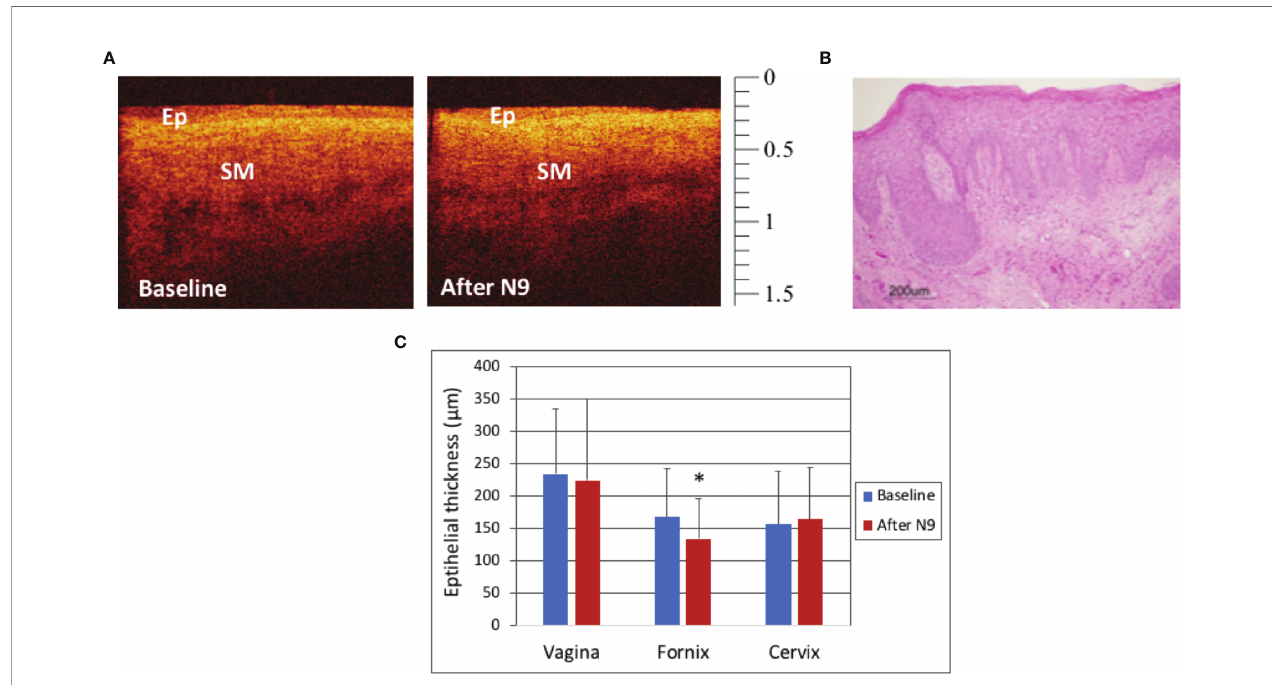
FIGURE 4 | Optical Coherence Tomography (OCT) and Histology Findings after 2 doses of Nonoxynol-9 (N9, 14 hours apart) - OCT image of the fornix in a mensing macaque before and after N9 application (A) . The epithelium (Ep) had very subtle changes with slight thinning in the fornix noted after N9. (OCT calibration bar is in mm, with small tick mark = 100 m m). Hematoxylin and Eosin (H&E) staining of vagina of a mensing macaque after N9 ( B , scale bar 200 m m). Epithelial thickness before and after 2 doses of N9 (14 hours apart) was signi fi cantly thinned in the fornix ( C , p=0.031), however there were no signi fi cant changes in the vagina (p=0.51) or cervix (p=0.87). Error bars represent standard deviation and asterisk (*) indicates signi fi